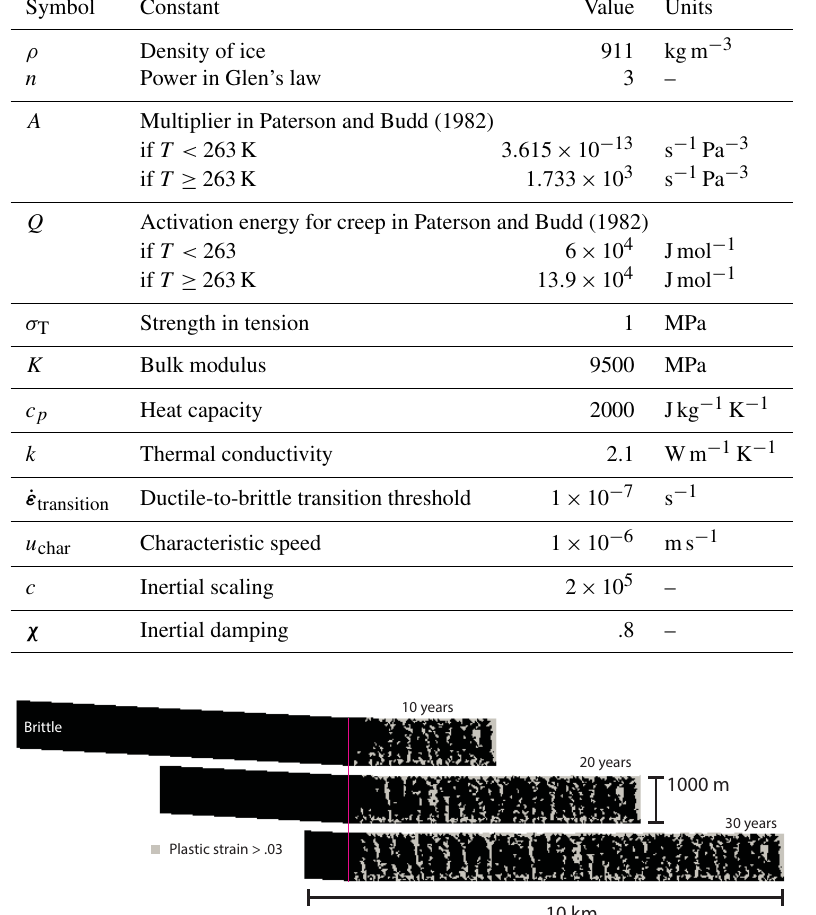
Figure 4. Simulation of brittle ice slab being advected down the inclined plane throughout the model time. Pink vertical line denotes the change in the angle of applied velocity boundary conditions from 3 ◦ to flat. Black ice indicates completely intact ice, while grey represents ice that has failed. Grey vertical lines appear with